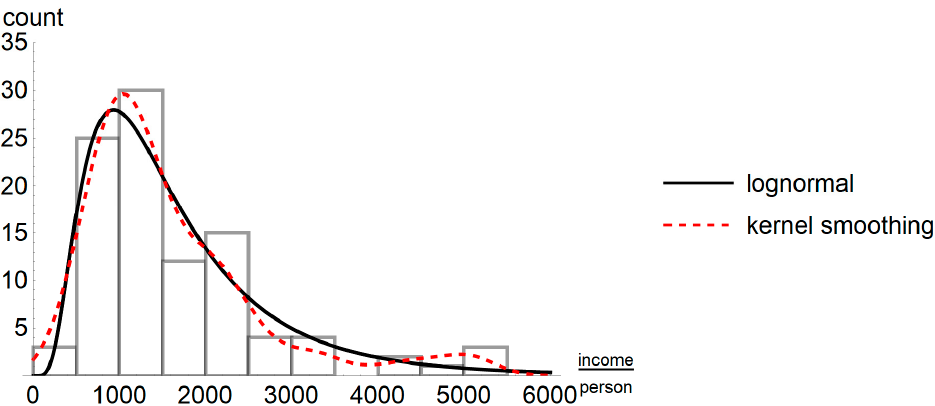
Figure 4. Histogram of per capita HH-incomes (INR (Indian Rupees, Rs)/month) of the slums (100 data, exceptionally large incomes were considered for fitting the distribution parameters, but not plotted) and related probability density functions; lognormal distribution (black) with maximum-likelihood parameters m = 7.23, s = 0.63 (good fit confirmed by the Cramér-von Mises distribution fit test: p -value 7%) and smooth-kernel distribution of the data (dashed). To obtain comparable scales the probability density functions were multiplied with 50,000 (100 data times 500 bin width); plot and computations: Mathematica 11.3.